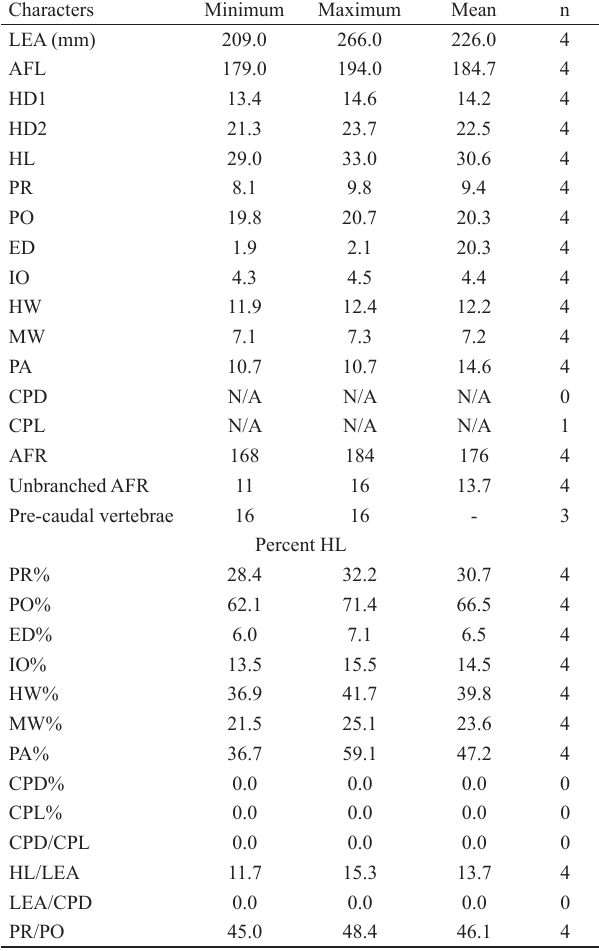
Fig. 16. Sternarchella duccis (ANSP 200514). a. Lateral view of the body, b. Lateral view of the head, c. Lateral view of the caudal region. Scale bars = 1 cm. Tab. 5. Morphometrics and meristic measurements for Sternarchella duccis